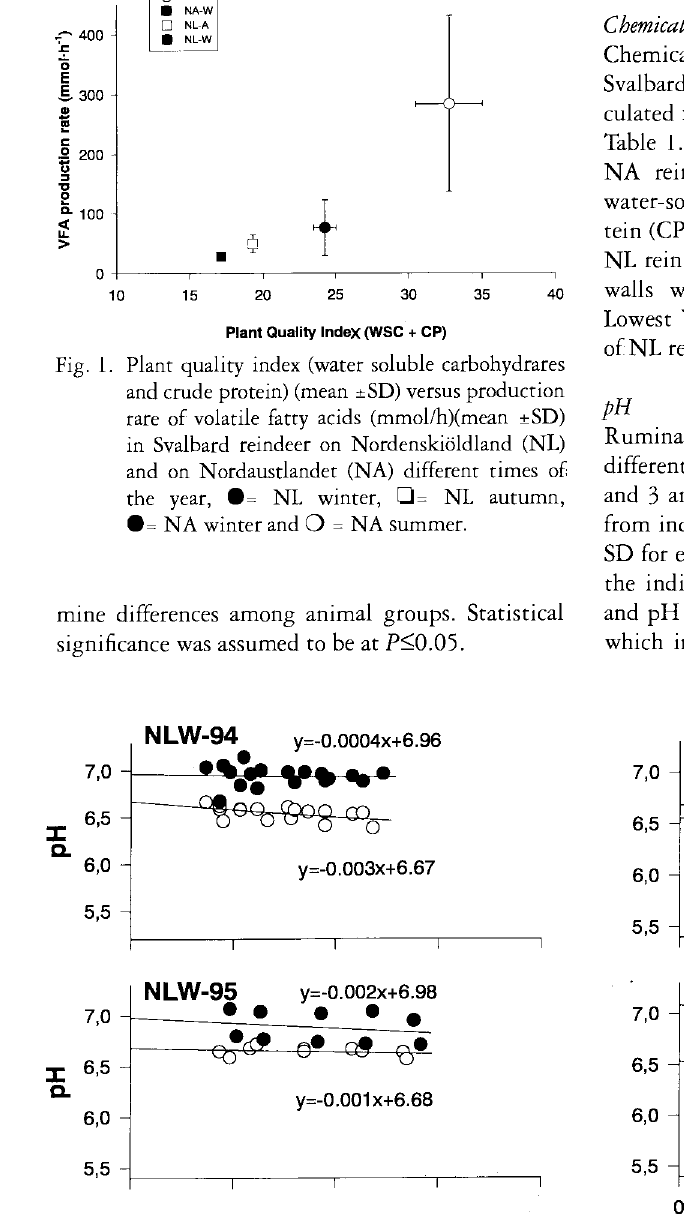
Fig. 2. Regression lines plot for the pH in the rumen (O) and in the distal fermentation chamber (•) of Svalbard reindeer at Nordenskioldland (NL) and on Nordaustlandet (NA) different times of the year as a function of time. (W=winter. A=autumn.